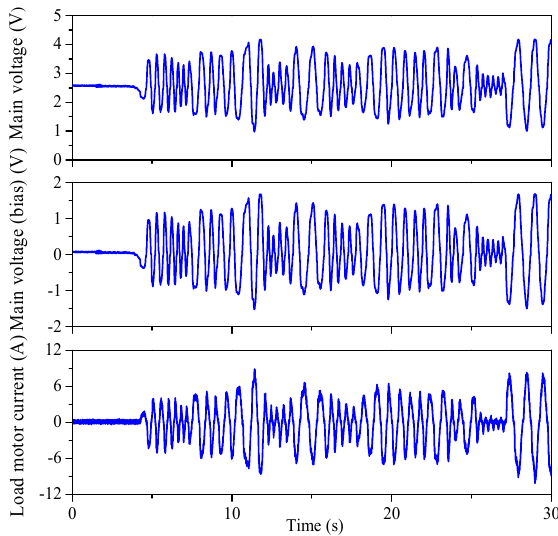
Figure 20. Input and output of the EPS identification system.